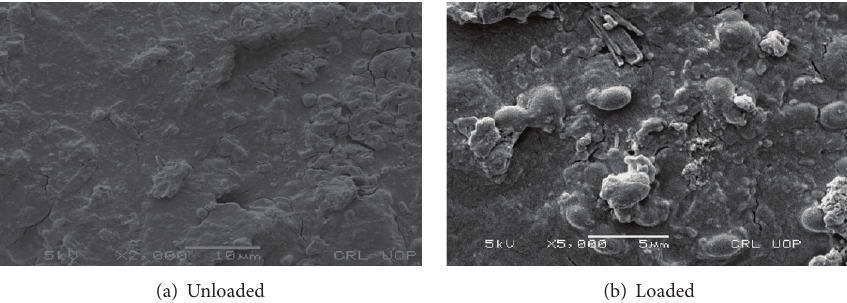
Figure 19: Surface electron micrographs (SEM) of AA/Gelatin hydrogels of sample U 6 : (a) magnification × 2000, (b) magnification ×